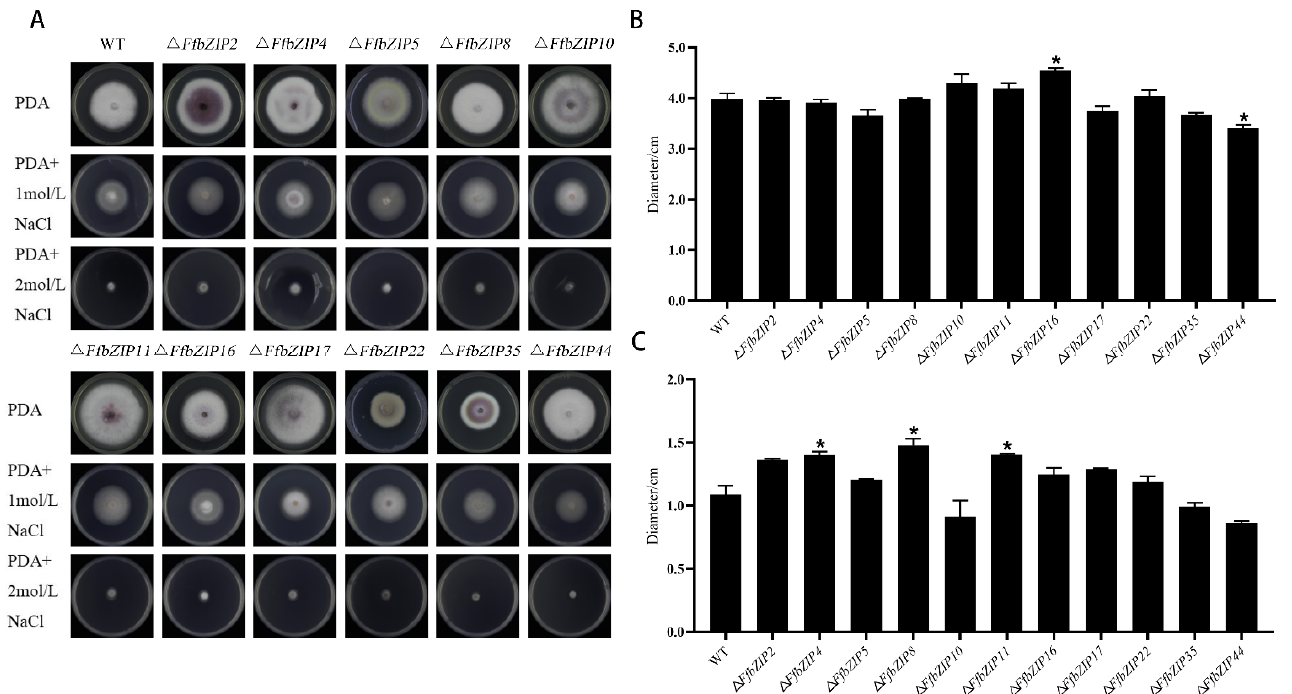
Figure 6. Osmotic stress experiment. ( A ) Growth of wild type and FfbZIP knockout mutants under NaCl osmotic stress. ( B ) Histogram of strain diameter under 1 mol/L NaCl osmotic pressure. Error bars represent means ± SEs. ( C ) Histogram of Histogram of strain diameter under 2 mol/L NaCl osmotic pressure. Error bars represent means ± SEs. * p < 0.05.